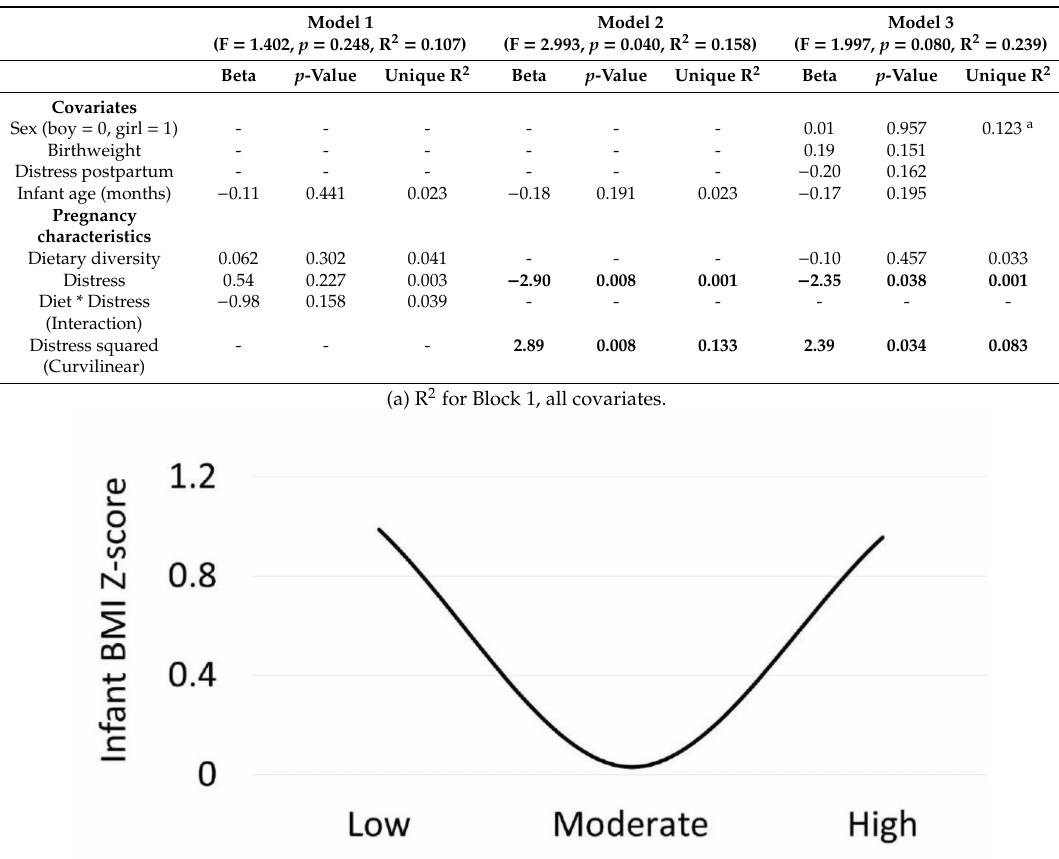
Table 1. Summary of regression models testing predictors of body mass index (BMI)-Z scores. Beta = standardized regression coe ffi cient. Significant values in bold.